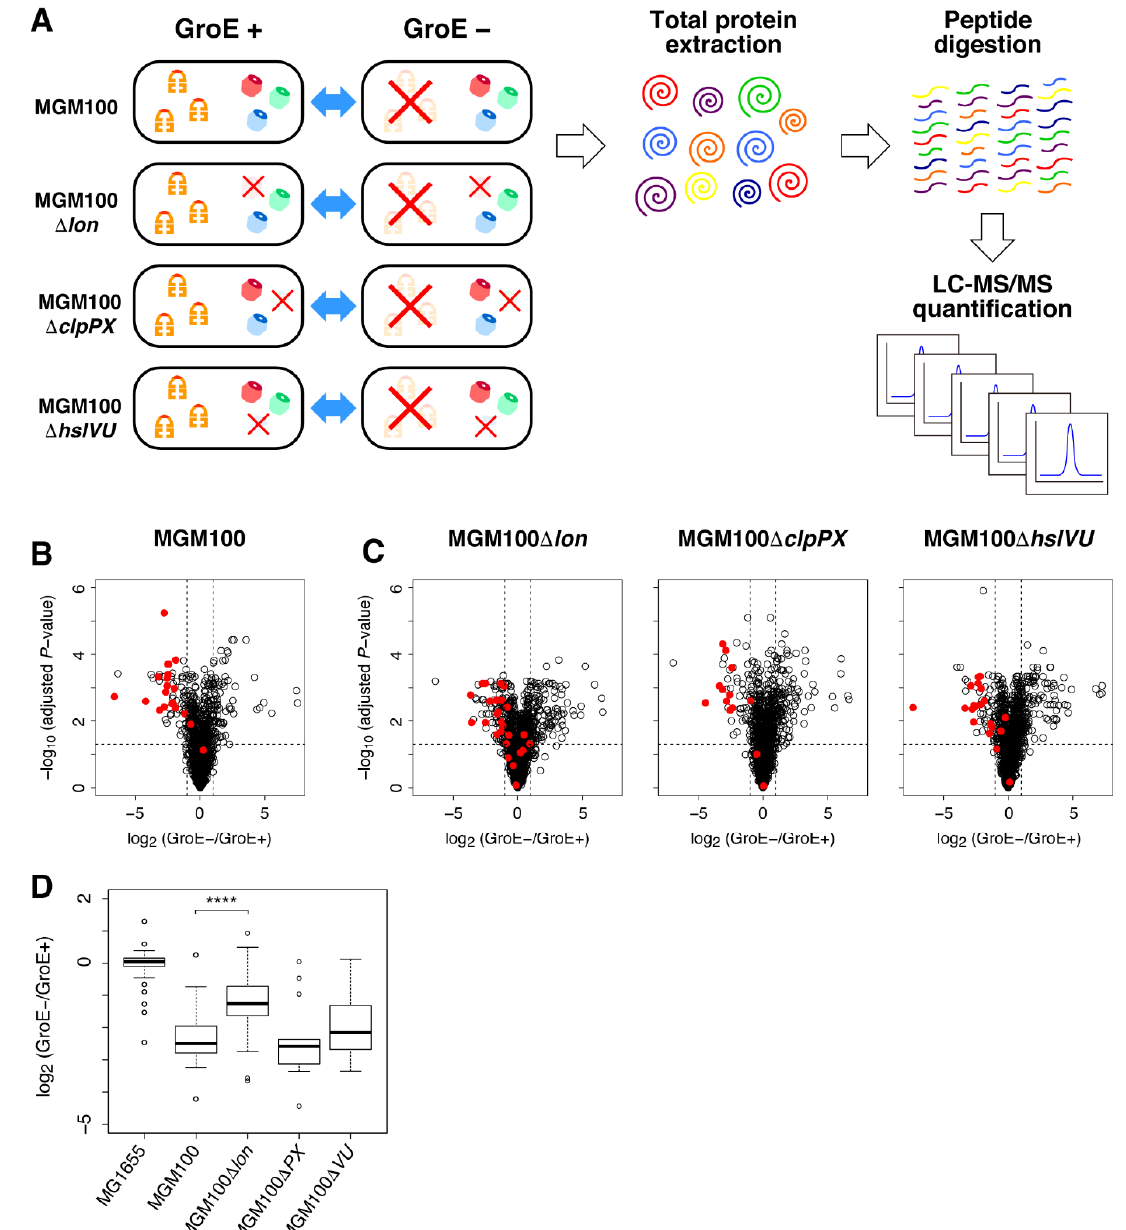
Figure 1. Proteome changes of the in vivo obligate GroE substrates by GroE depletion. ( A ) Schematic illustration of the experiment. The wildtype cells and the protease deletion variants were grown under the GroE-normal and GroE-depleted conditions. The total proteins were then extracted and digested into peptides by the Lys-C/Trypsin proteases. The digested peptides were measured and quantified by LC-MS/MS. ( B ) Proteomic changes in MGM100 by GroE depletion represented as a volcano plot. The horizontal axis indicates the value of the fold changes by the GroE depletion taken as log 2 , and the vertical axis indicates p -values by Welch’s t -test (two-sided) with three technical replicates in each sample taken as − log 10 . For multiplicity correction, the p -values are adjusted by the Benjamini-Hochberg method. Red dots indicate the in vivo obligate GroE substrates. ( C ) Proteomic changes in the MGM100-derived protease-deletion strains by the GroE depletion, depicted as volcano plots. Red dots indicate the in vivo obligate GroE substrates. ( D ) Distribution of the fold changes of the in vivo obligate GroE substrates in each strain depicted as a boxplot. The box portions and the central bands are described according to the 25th percentile and the median, respectively. **** p -value < 0.001 (Wilcoxon’s rank-sum test).